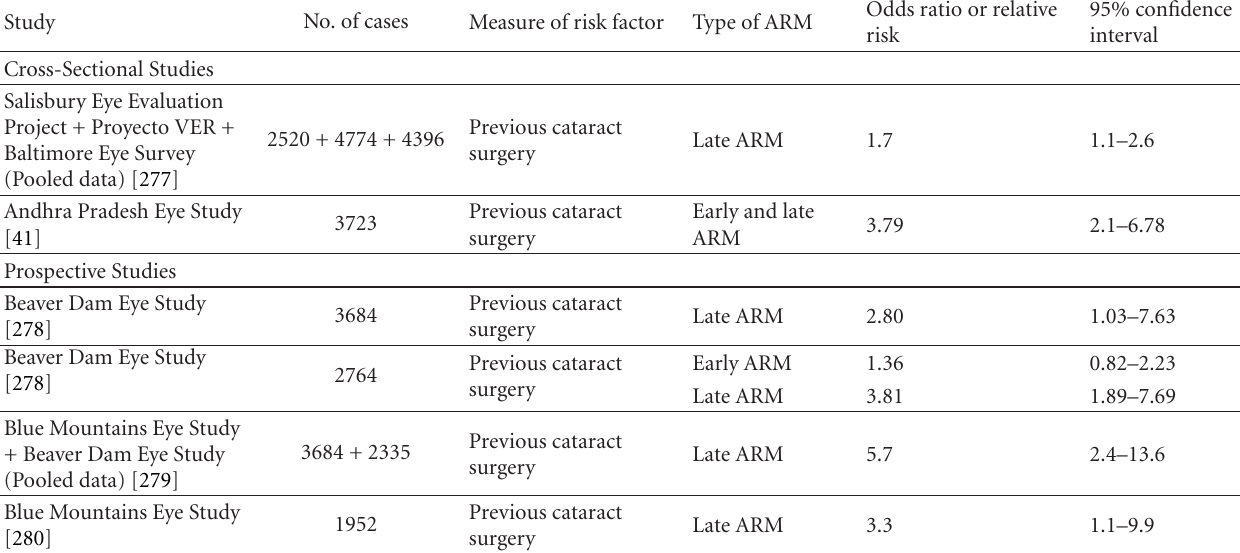
Table 19: Studies investigating the relationship between cataract surgery and risk for